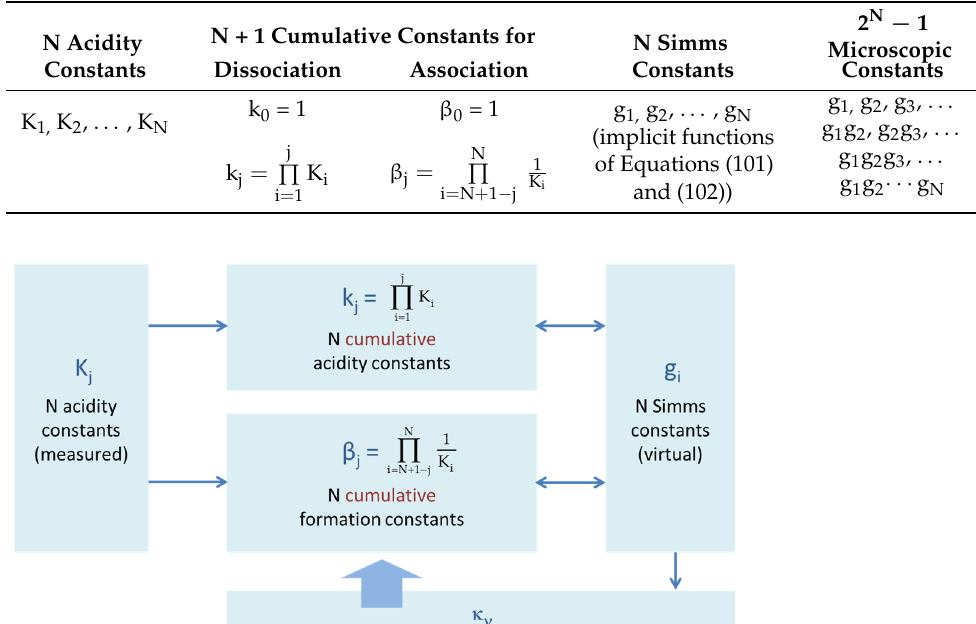
Table 4. Macroscopic and microscopic acidity constants.